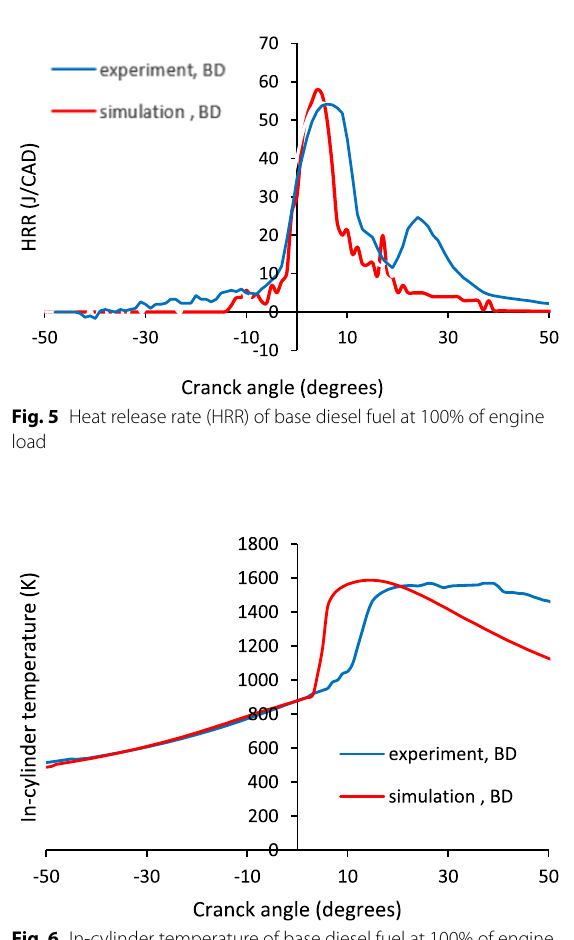
Fig. 6 In‑cylinder temperature of base diesel fuel at 100% of engine load